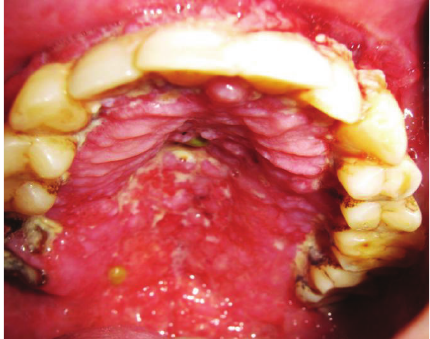
Figure 3: Involvement of hard and soft palate (cobblestone appear- ance of mucosa of the hard palate).